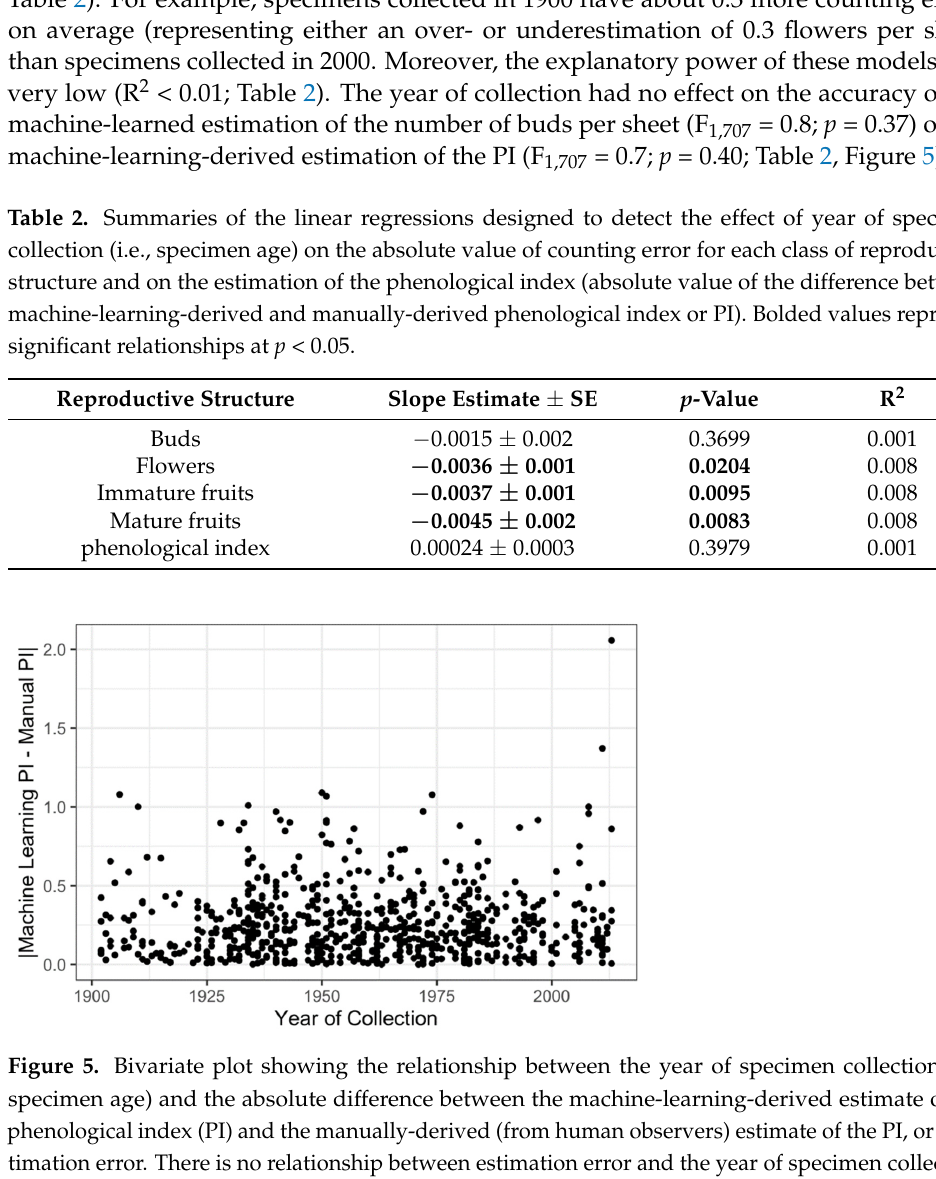
Table 3. Summary of the multiple linear regression designed to detect temporal shifts in flowering date while controlling for the phenological status as estimated by the (a) manually-derived or (b) machine-learning-derived phenological index (PI). Bold values represent significant effects at p < 0.05. a. Independent Variable